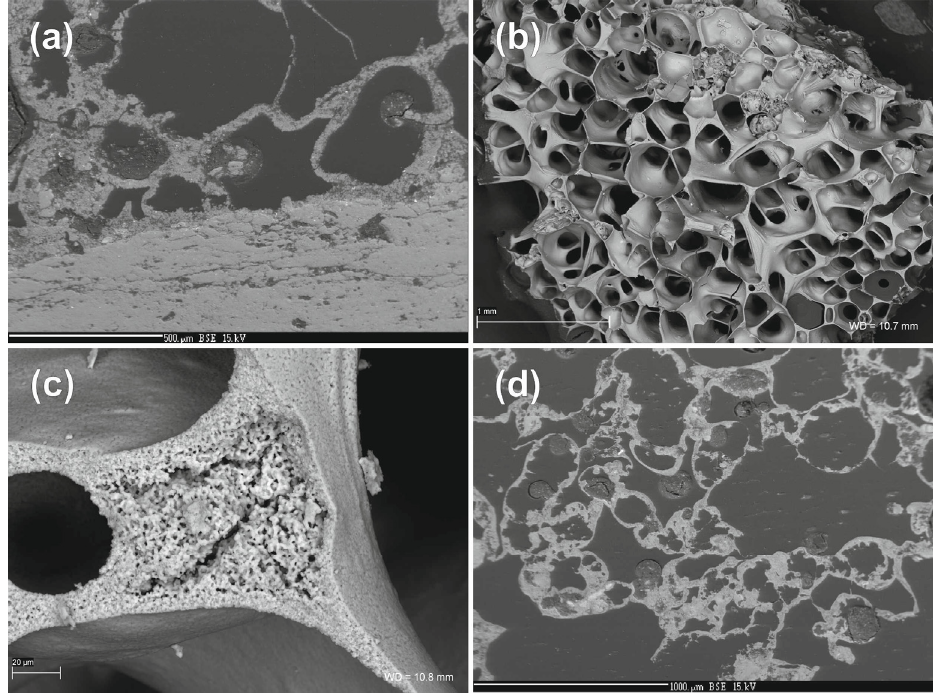
Figure 8. ( a ) Contact between clinker and overgrowing millosevichite foam, back scattered electronsimage (BSE), ( b ) typical vesicular structure of millosevichite (SEM), ( c ) details of microcrystalline millosevichite film around gas bubbles (SEM), ( d ) the order of microcrystalline steklite growth around gas bubbles (BSE); Rydu ł towy.